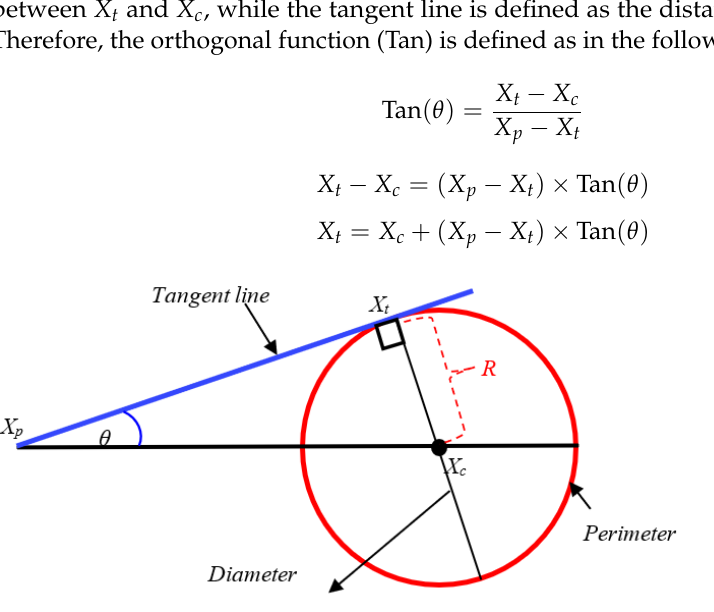
Figure 2. Terms of the geometrical circle.